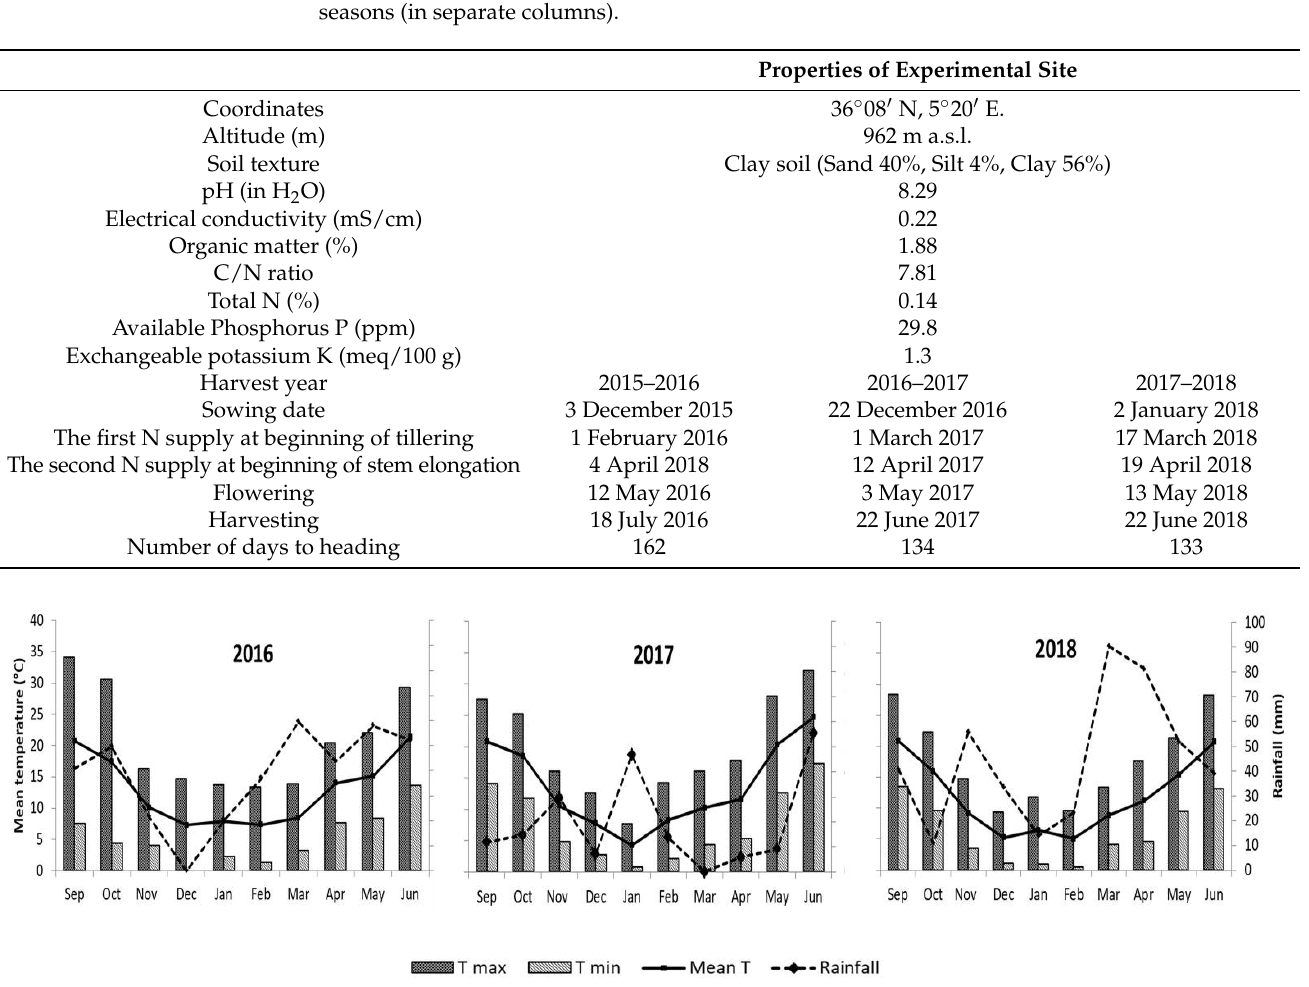
Figure 1. Monthly precipitation and minimum, maximum, and mean temperatures during the three cropping seasons (2016 = 2015/16; 2017 = 2016/17; and 2018 = 2017/18). Table 1. Experimental details and dates of the main phenological stages during the three cropping seasons (in separate columns).